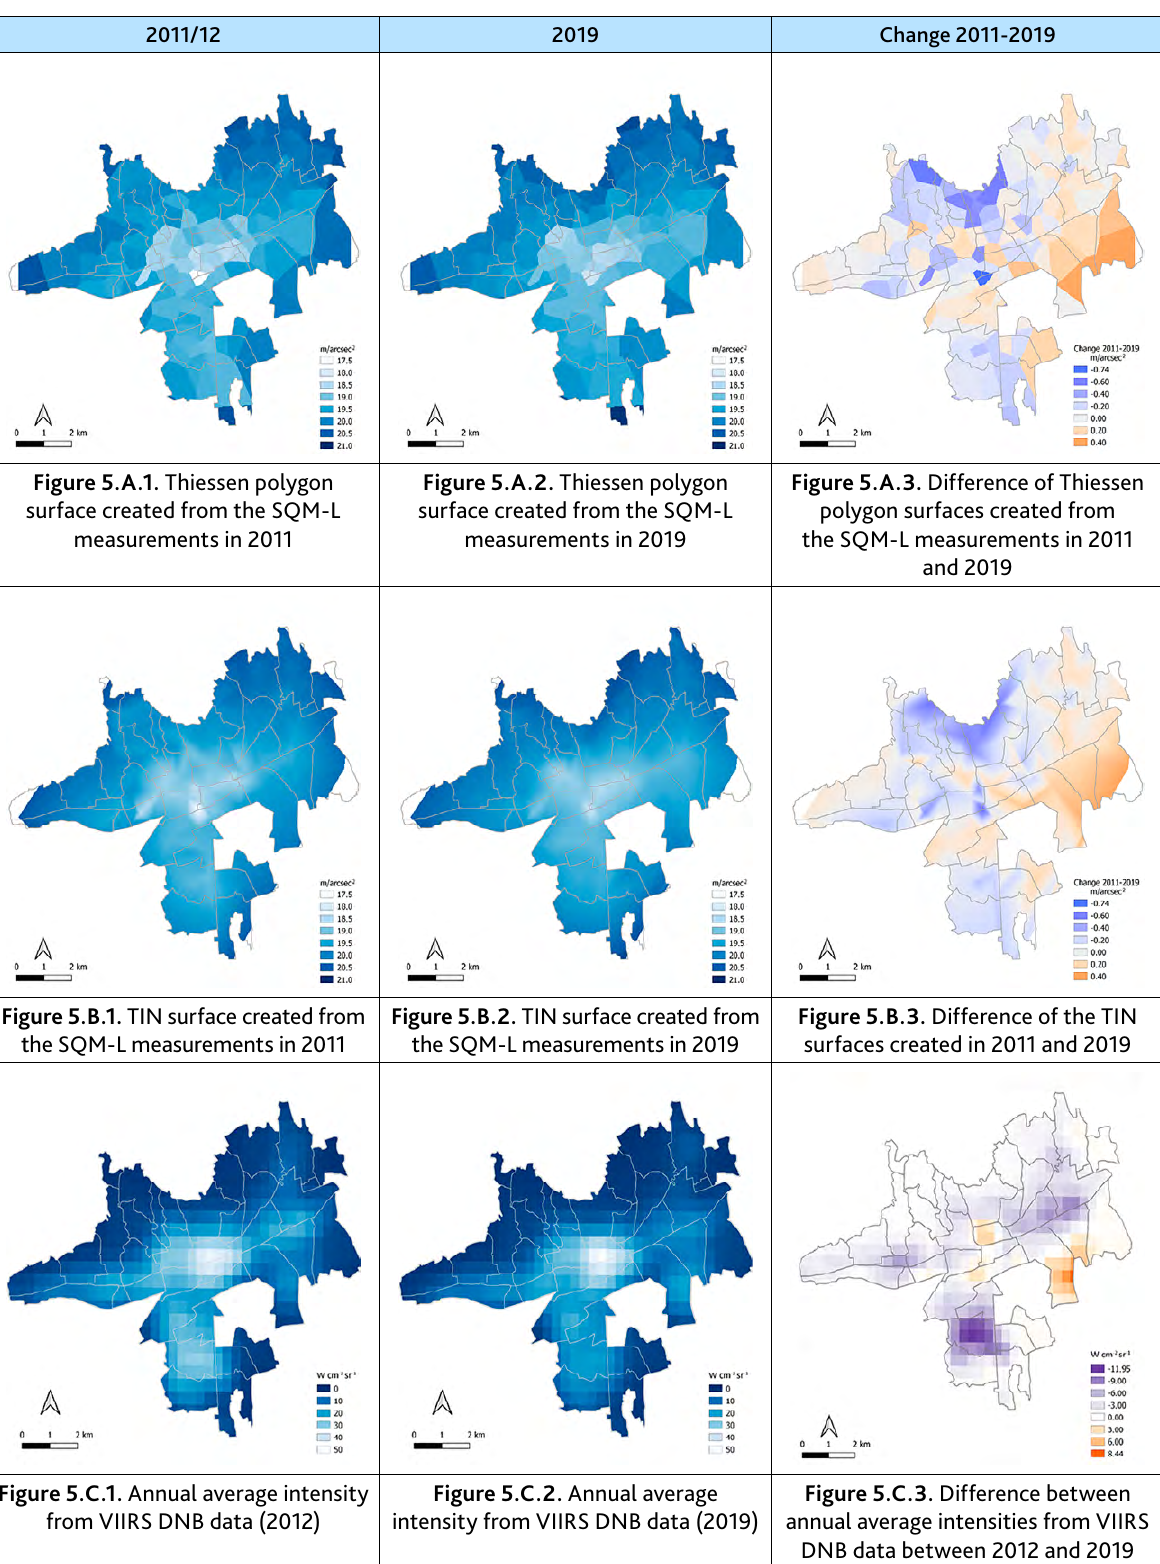
Figure 5.C.2. Annual average intensity from VIIRS DNB data (2019)